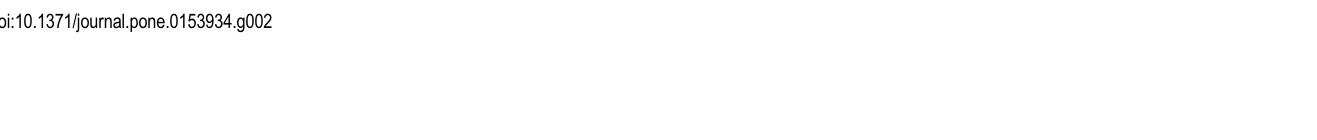
PLOS ONE | DOI:10.1371/journal.pone.0153934 April 20,